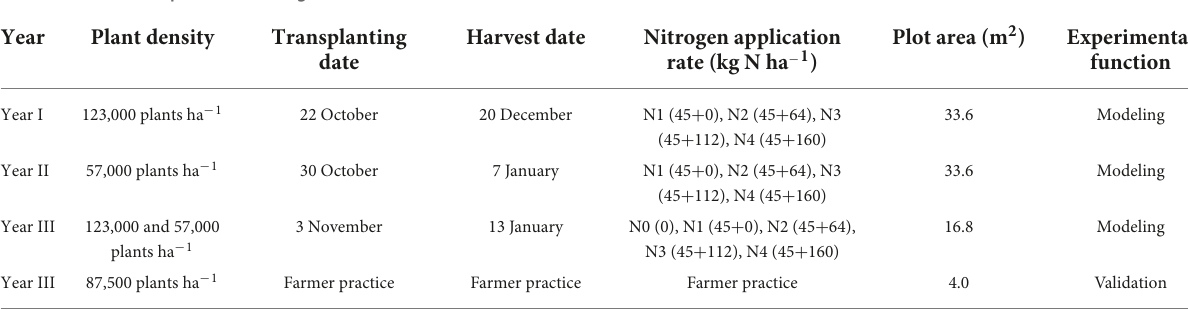
TABLE 1 Detailed experimental